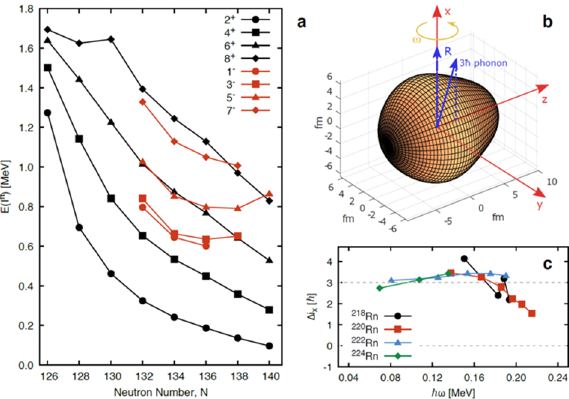
Figure 4. Systematic behaviour of radon isotopes . (a) Systematics of the energies for different spins of low-lying positive-parity (black) and negative-parity states (red) in radon isotopes; (b) cartoon illustrating how the octupole phonon vector aligns with the rotation ( R ) vector (which is orthogonal to the rotating body’s symmetry axis) so that I = R +3 (c) difference in aligned spin for negative- and positive-parity states in 218-224 Rn (re-analysed for 218-222 Rn that have been presented earlier [23]). The dashed line at expected value for static octupole deformation.